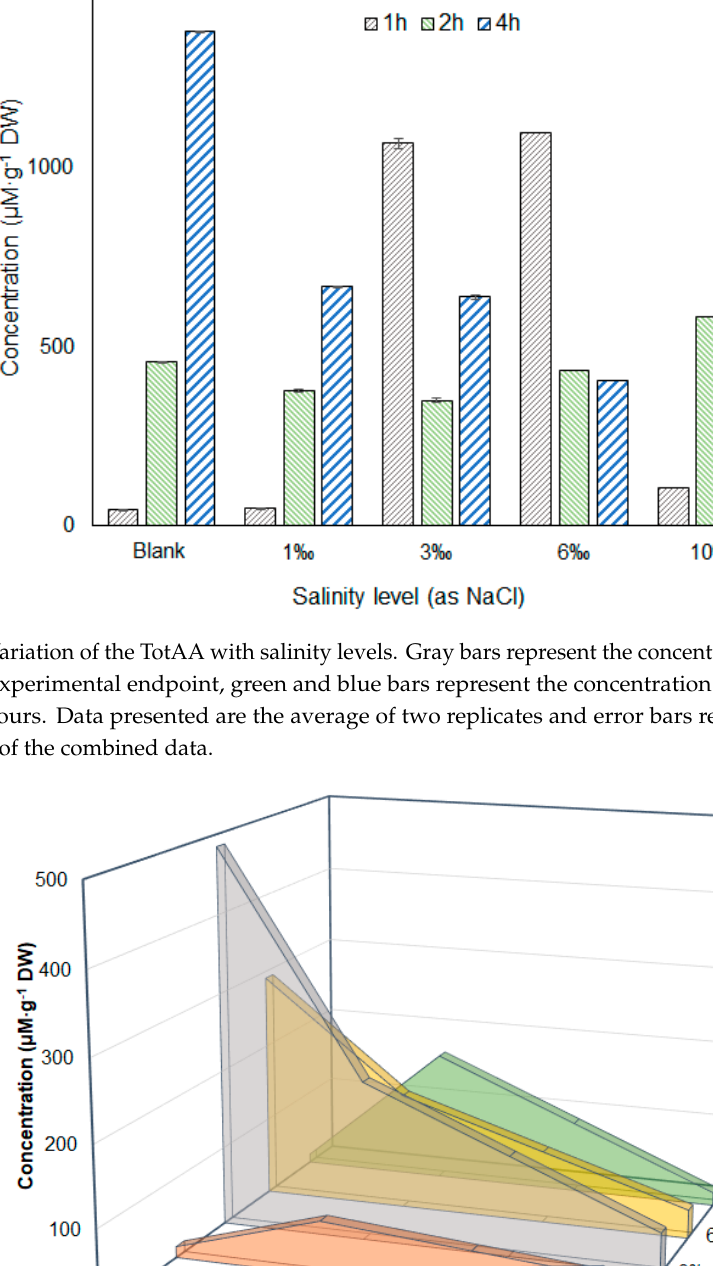
Figure 3. Variation of concentration of proline along with time at different salinity stress.